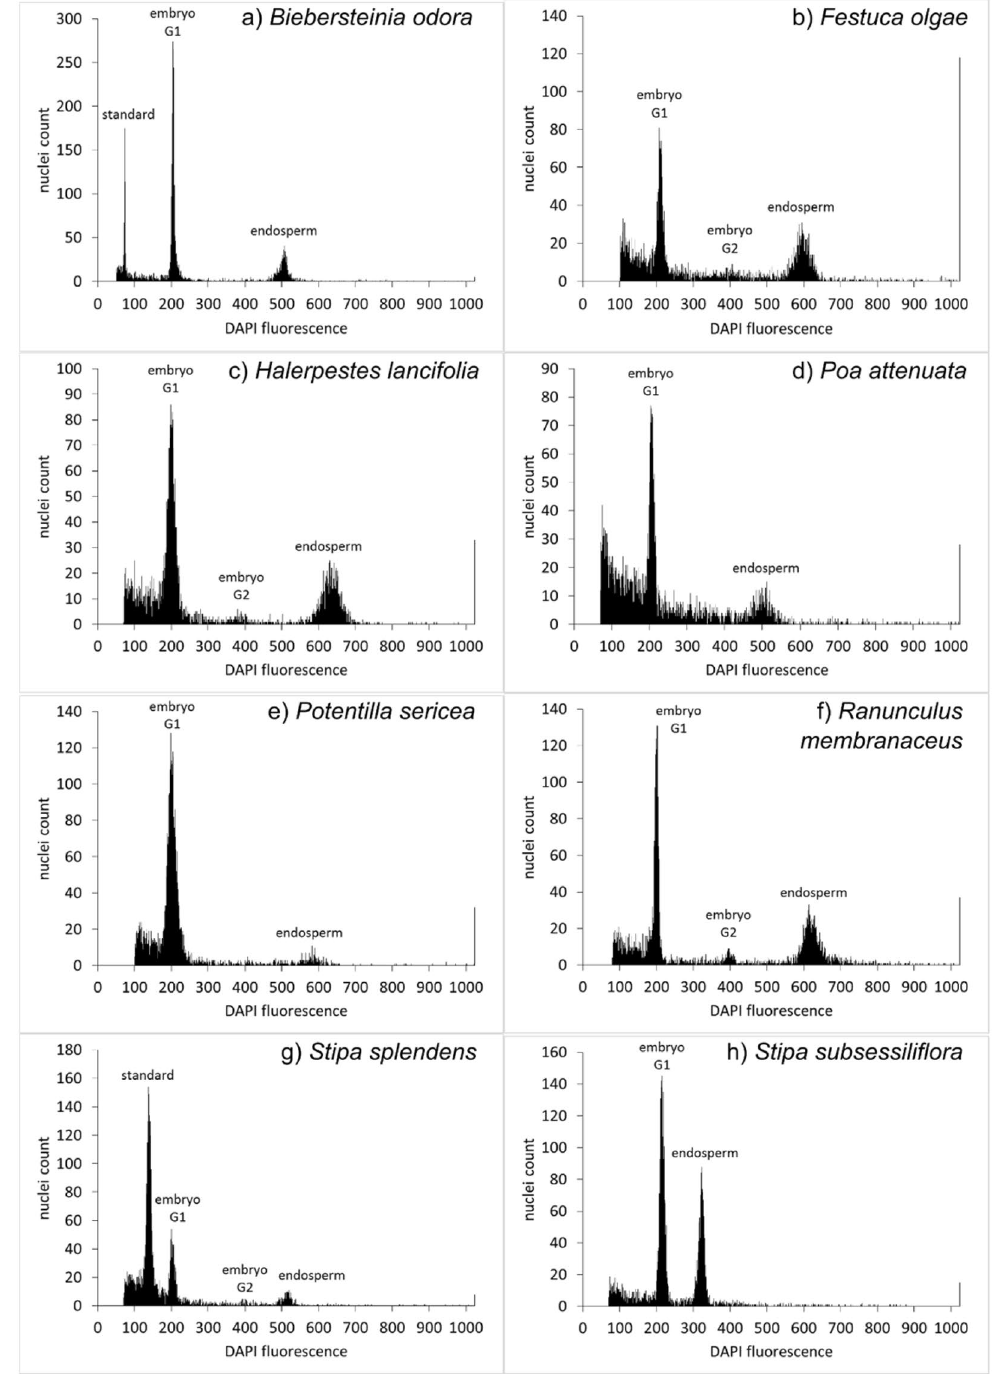
Figure 3. FCSS histograms of selected apomictic species and a sexual species Stipa subsessiliflora . Peeks show the amount of nuclei with relative DNA amount represented by intensity of DAPI